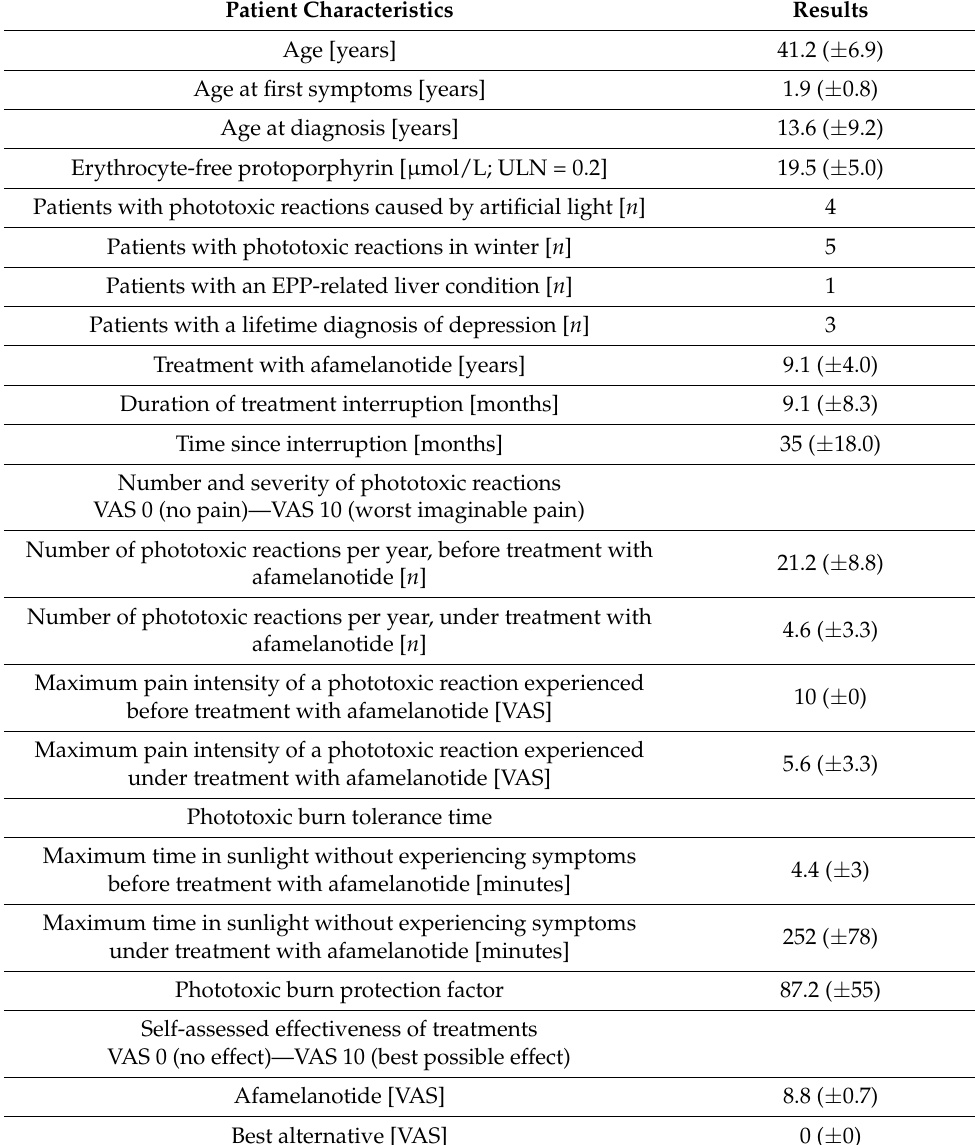
Table 1. Patient characteristics data. Patient characteristics data of the five participants in means (SD), if not stated